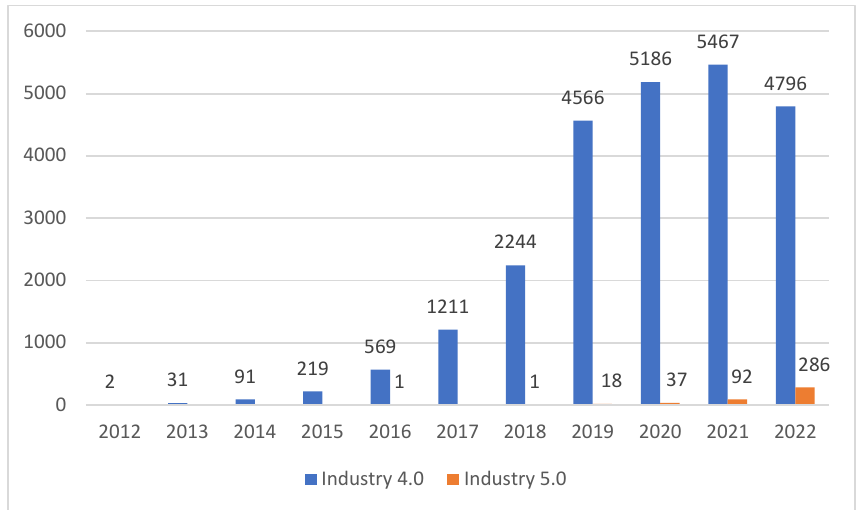
Figure 1. Volume of publications on Industry 4.0 and 5.0 (Source: Scopus).